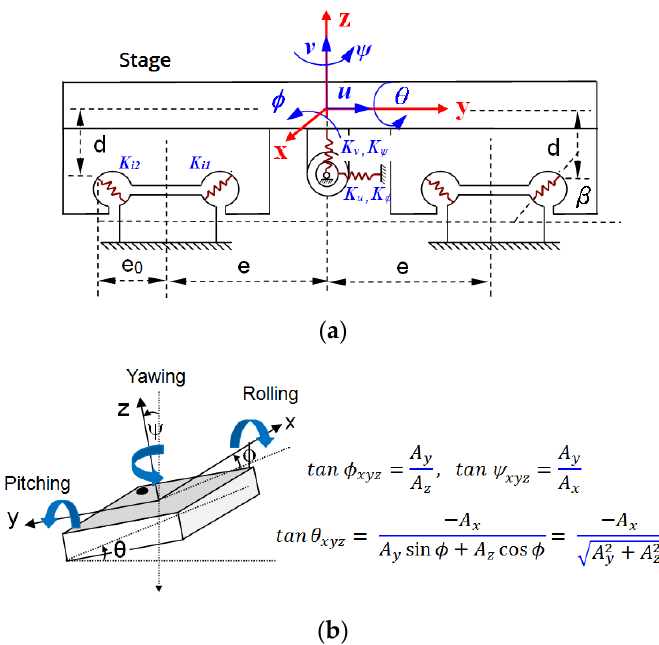
Figure 12. Schematic of dynamic model and angular motion of stage: ( a ) dynamic model of stage [41] and; ( b ) derivation of angular acceleration [42].